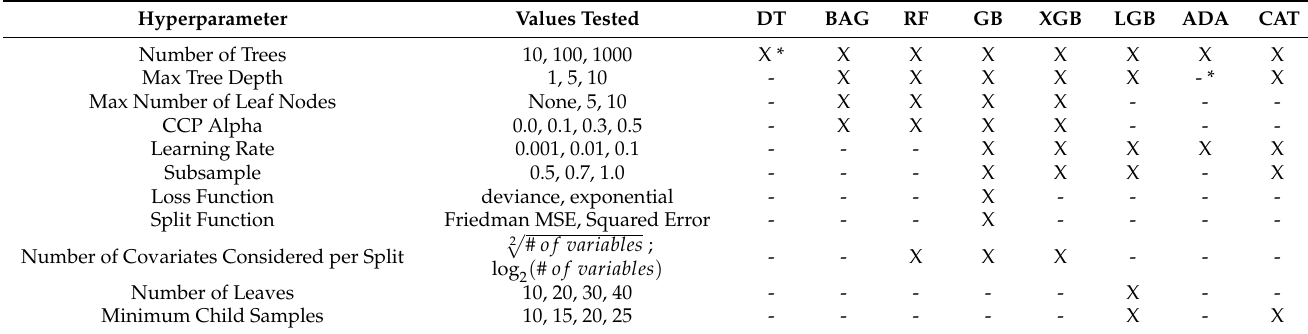
* An ‘X’ indicates that the hyperparameter was tested and a ‘-’ indicates that the hyperparameter was not applicable. Once tuned, the finalized models predicted woody plant cover for the 1.0 km 2 image tile that each training plot was contained within. A total of 20 image tiles were predicted plots fell within the same image tile. The results from each model were exported as a